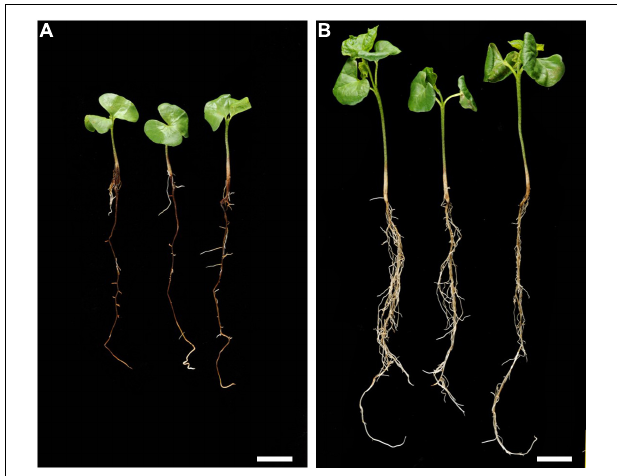
FIGURE 5 | Parental phenotypes of the (A) BRR infected and susceptible YZ; and (B) the BRR infected and resistant BM13H infected seedlings 25 days after germination in soil with BRR spores. Bars = 2 cm. Adapted from Wilson et al. (2021) and is licensed under CC BY